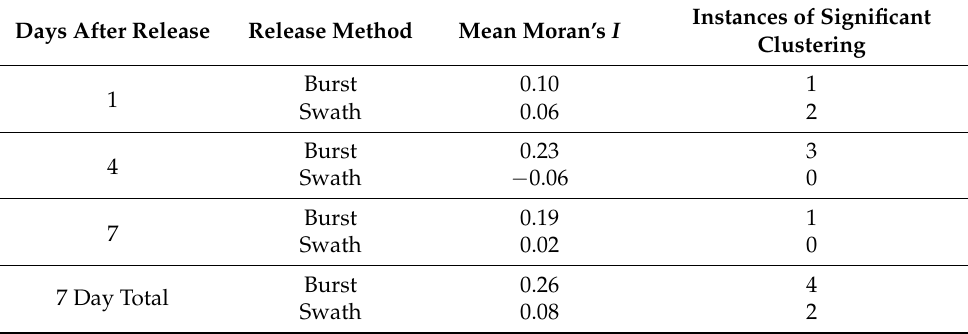
Table 2. Summary of Moran’s I values for each release strategy (burst or swath) collection after release ( n = 4). I values Scheme 4 where a Monte Carlo procedure identified clustering to be more significant than random ( p < 0.05). Days After